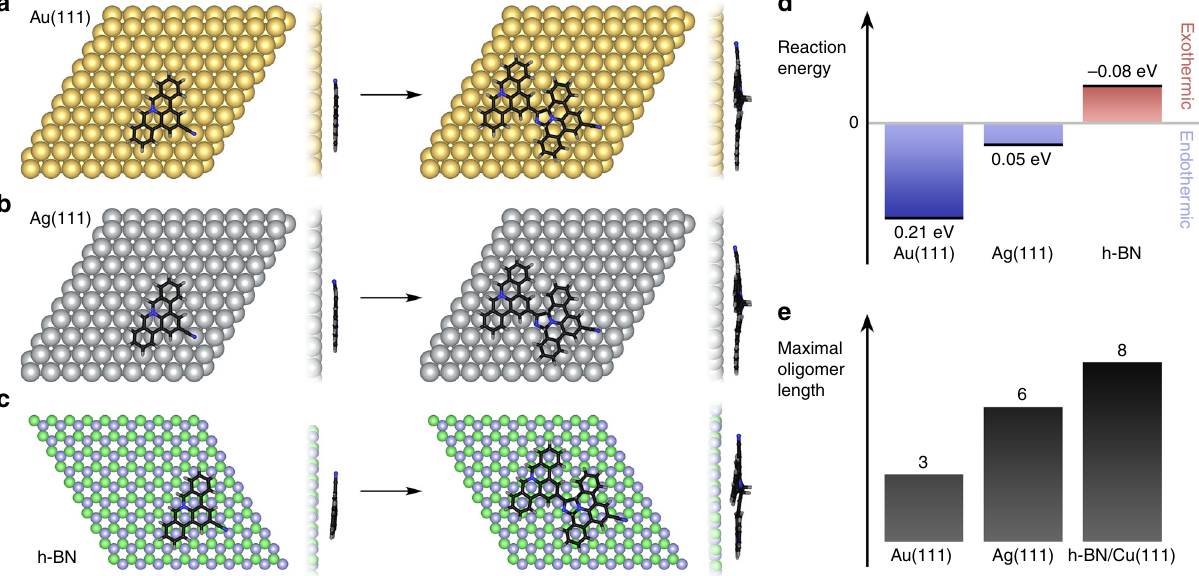
Fig. 7 DFT reaction study of the dimerization step of 1a. Top and side views of 1a and 2a -type dimers on ( a ) Au(111), ( b ) Ag(111), and ( c ) h-BN. d The computed reaction energies show that the reaction step is endothermic on Au(111) and Ag(111) and slightly exothermic on h-BN. e Maximum oligomer lengths observed experimentally on Au(111), Ag(111), and